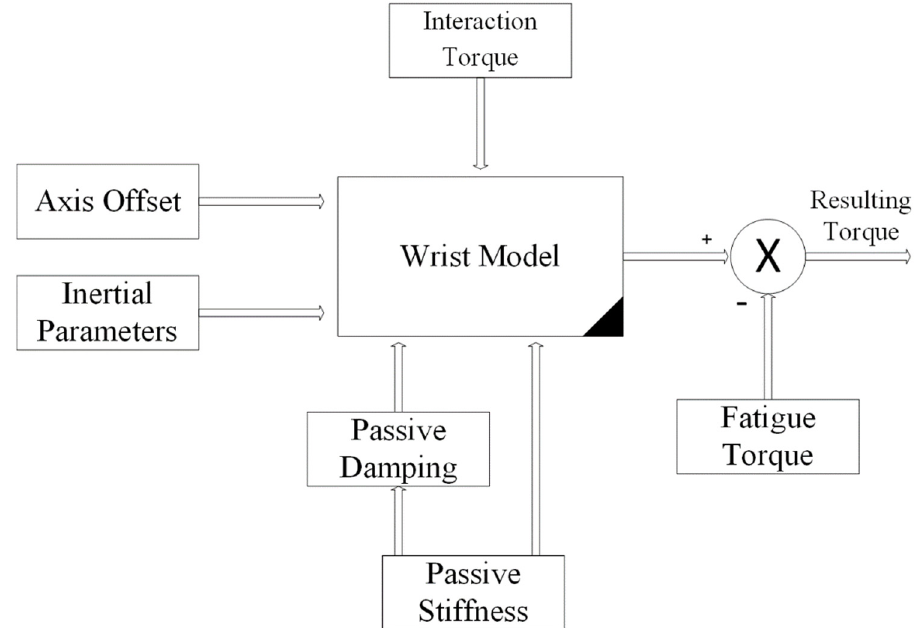
Figure 6. Wrist model and resulting torque.